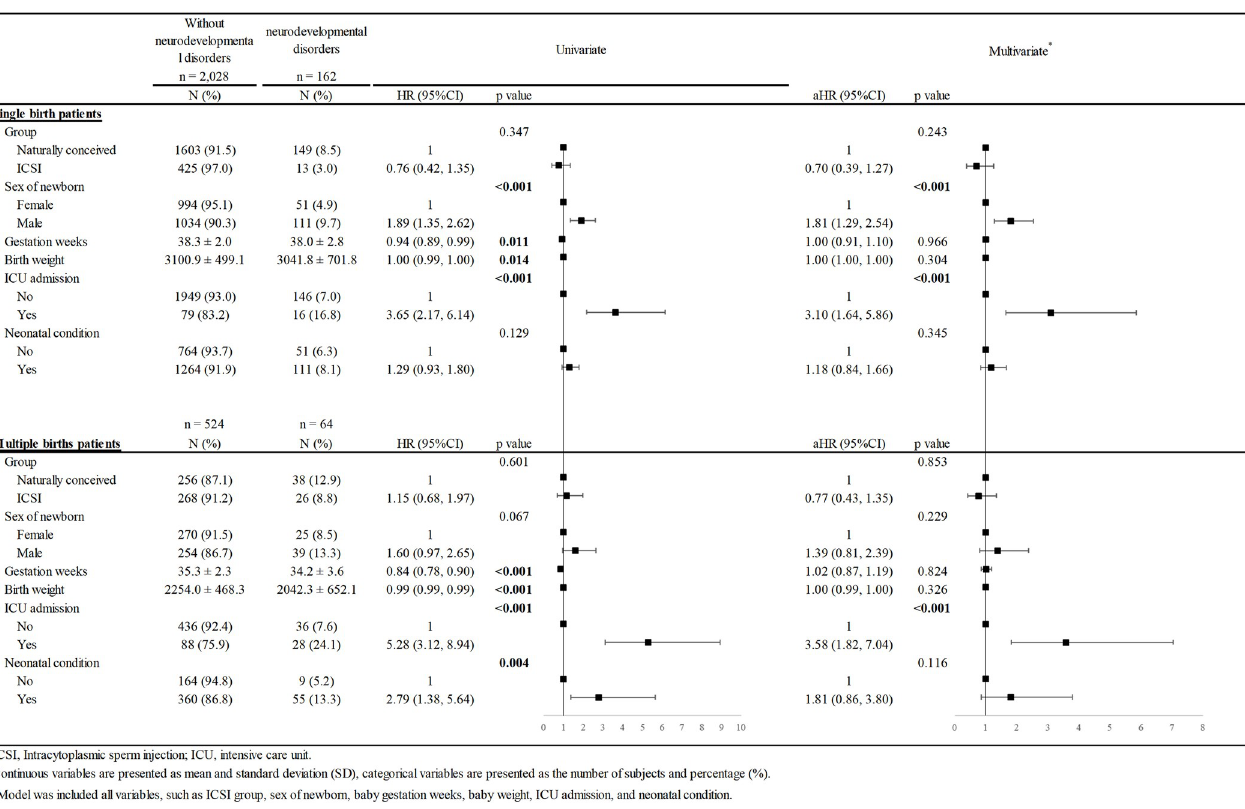
Fig 2. Univariate and multivariate cox regression analysis of neurodevelopmental disorders in subgroup analysis.